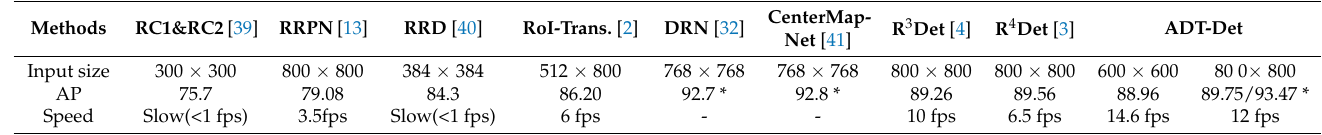
Table 4. Evaluation results with the accuracy and speed of some well-known detectors on HRSC2016. All models were evaluated under ResNet-152. * indicates that the result was evaluated under the PASCAL VOC2012 metrics.